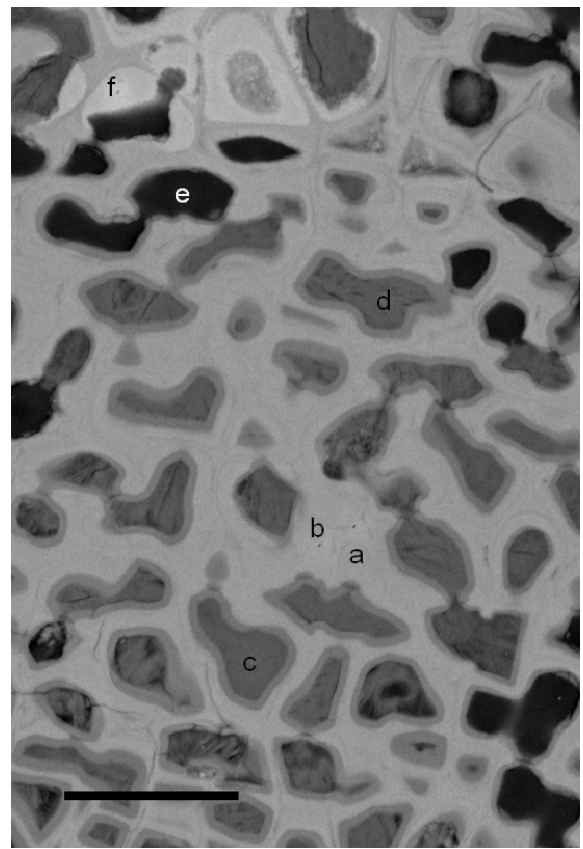
Fig. 3. SEM BSE (SE) image of aragonite-bearing coralline al- gae (Sample 302) showing the typical fabric of protodolomite rims around cells that are partially to completely filled with magnesite. White rims at the top (f) are aragonite. Textures within cells may represent organic material, or mineralisation that was constrained by the organic fabric. Concentric zonations are seen within the cell wall material. SEM-EDS spot analyses of labeled sites, (a) = 11.32, (b) = 13.88, (c) = 98.44, (d) = 99.16mol% MgCO 3 , (e) = hole, (f) = 0.67 (Strontium = 1.69wt% indicative of aragonite). Scale bar = 20µm. Legend see Fig.